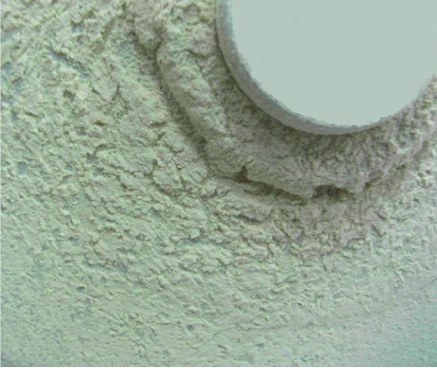
Figure 3: Phenolic resin powder. Figure 4: Phenolic resin recycled slat